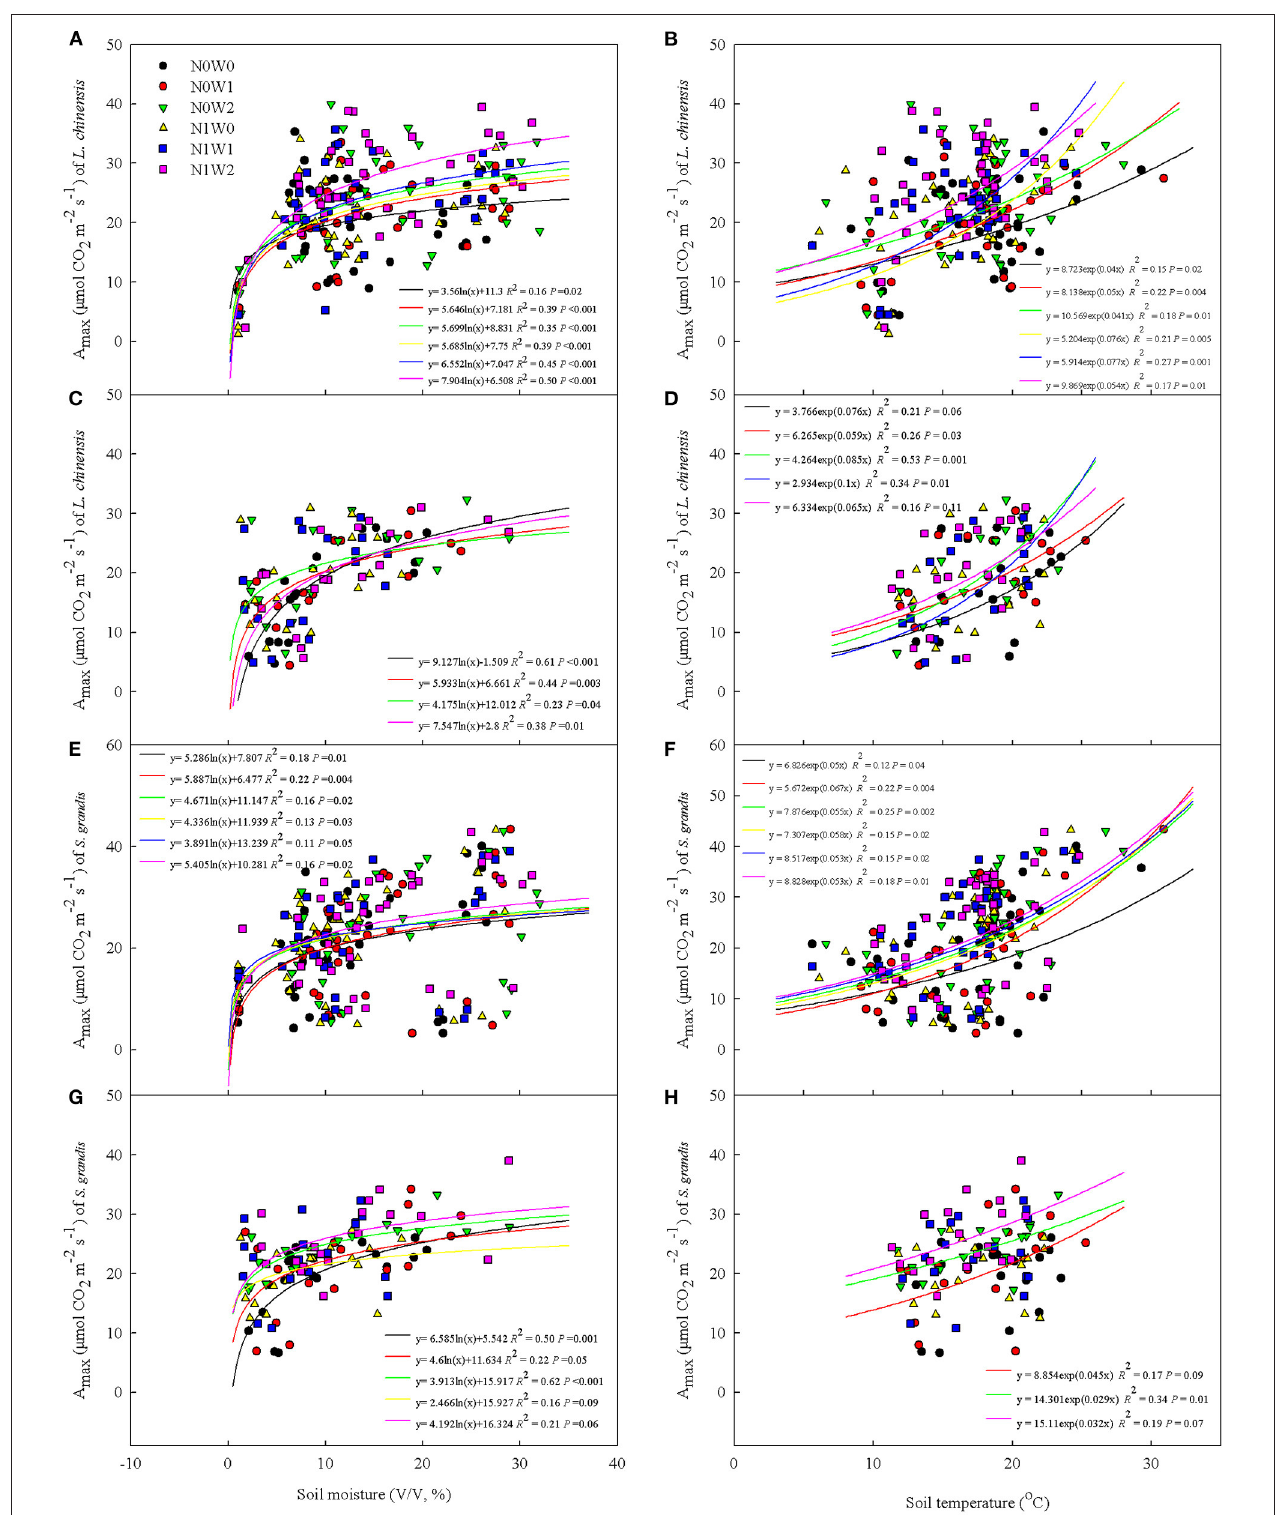
FIGURE 6 | Relationships of the maximum photosynthetic rate (A max ) with soil moisture (left panels) and soil temperature (right panels) of two dominant species across 2012 and 2013. (A,B) A max of Leymus chinensis in the early growing season (from end-May to mid-August), (C,D) A max of Leymus chinensis in the later growing season (from end-August to end-September), (E,F) A max of Stipa grandis in the early growing season (from end-May to mid-August), and (G,H) A max of Stipa grandis in the later growing season (from end-August to end-September).